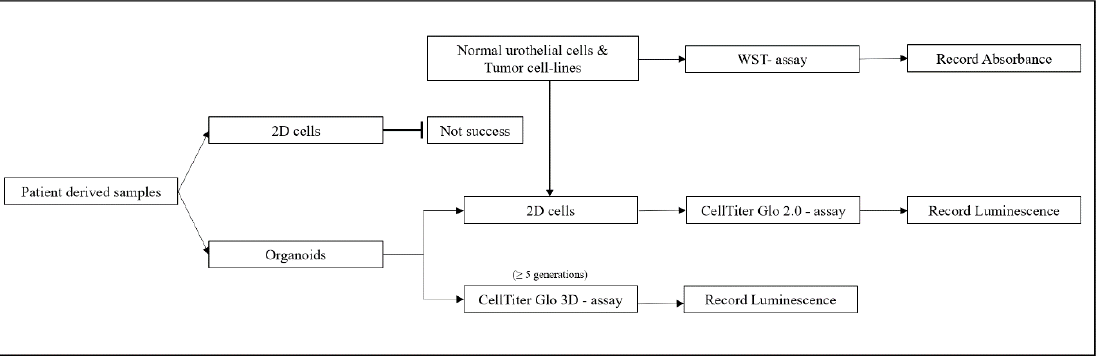
Figure 7. Graphical overview over the study